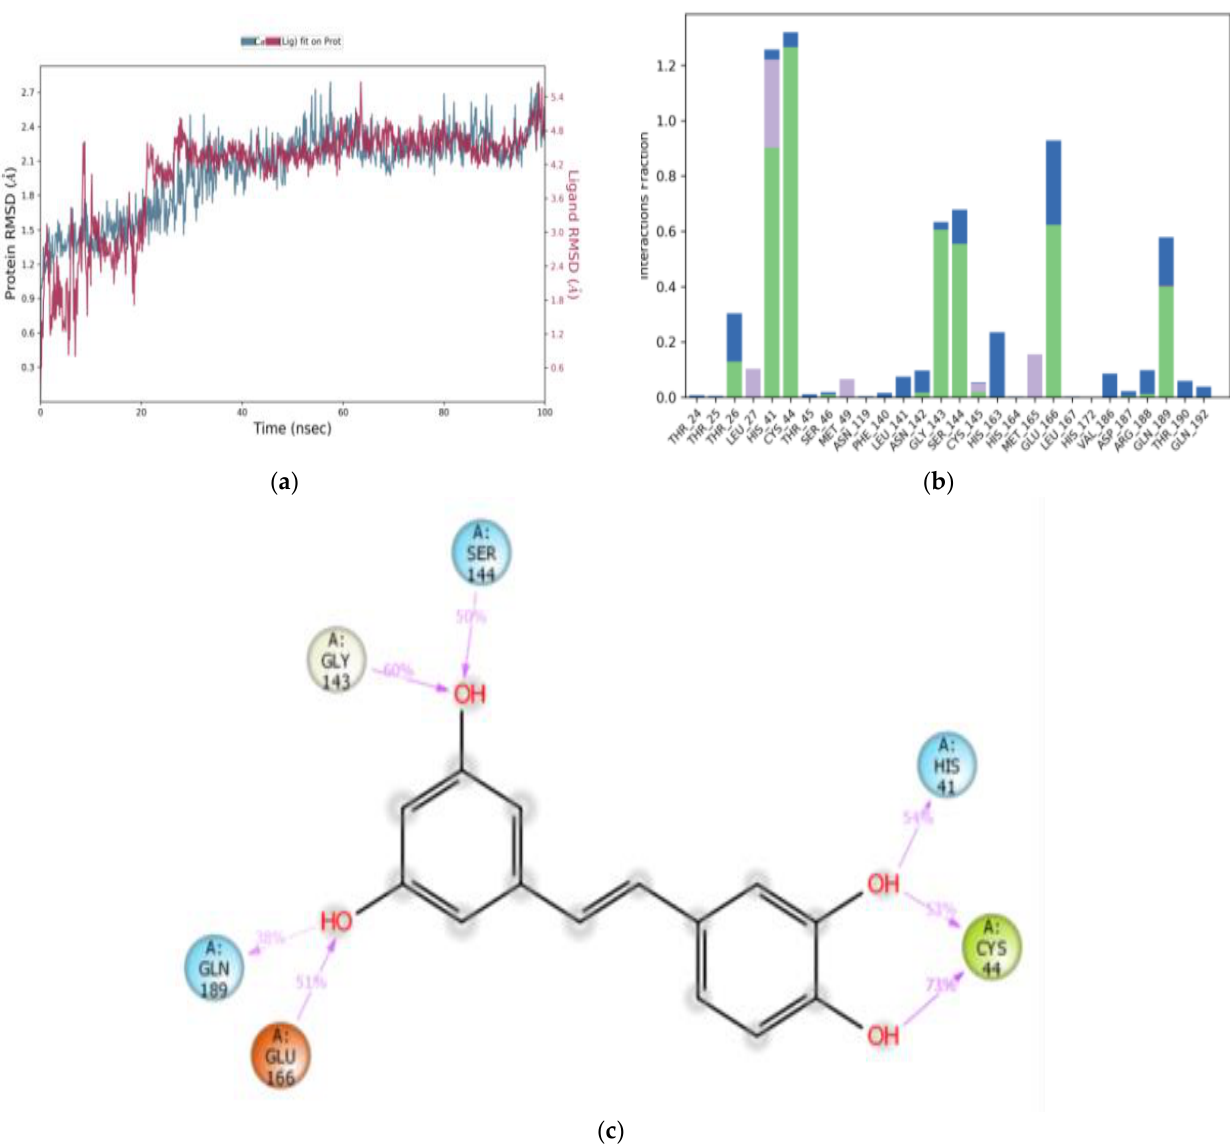
Figure 7. MD simulation studies of piceatannol (Structure 3) in complex with M pro . RMSD plot of protein backbone (Cα) and protein conformational change during ligand binding ( a ). Interaction fraction plot showing different protein residues that interact with piceatannol during a 100 ns MD simulation ( b ). Interaction of ligand atoms with the protein residues that occurs for >90% of the simulation time ( c ).